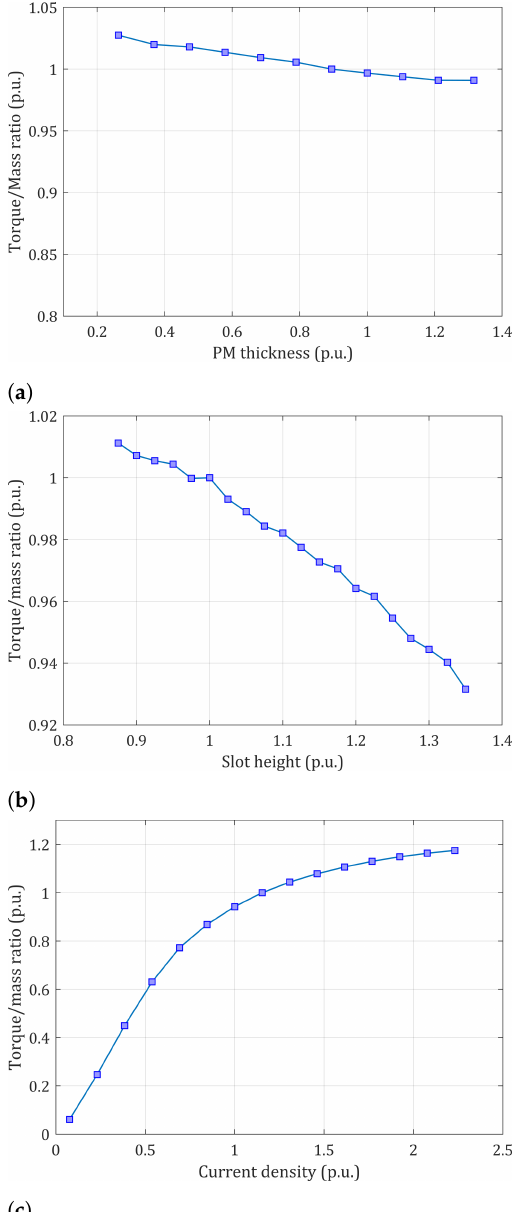
Figure 13. Torque density dependence on ( a ) PM thickness, ( b ), slot height and ( c ) current